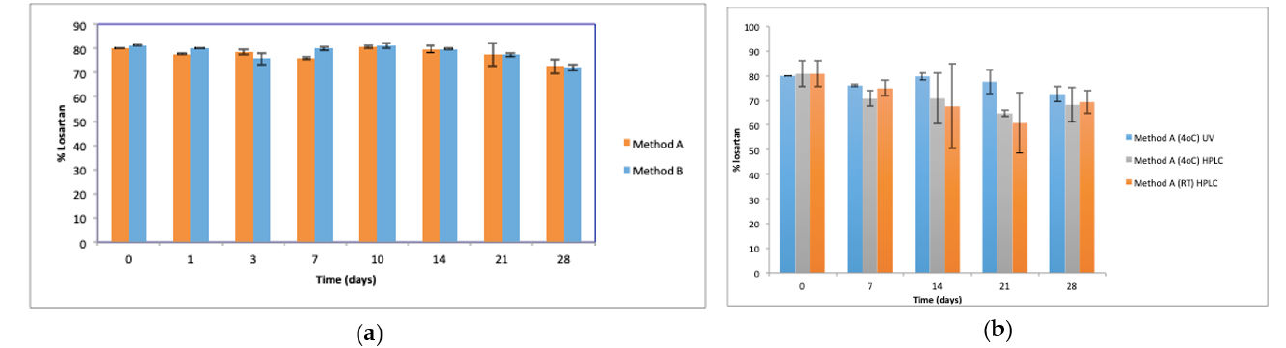
Figure 3. Losartan content of suspensions ( n = 3, ± SD, p > 0.05) ( a ) prepared by Methods A and B and stored at 4 ◦ C, assayed by UV ( b ) prepared by method A, stored at 4 ◦ C and RT, and analysed by UV and HPLC. Percent losartan content based on claimed losartan